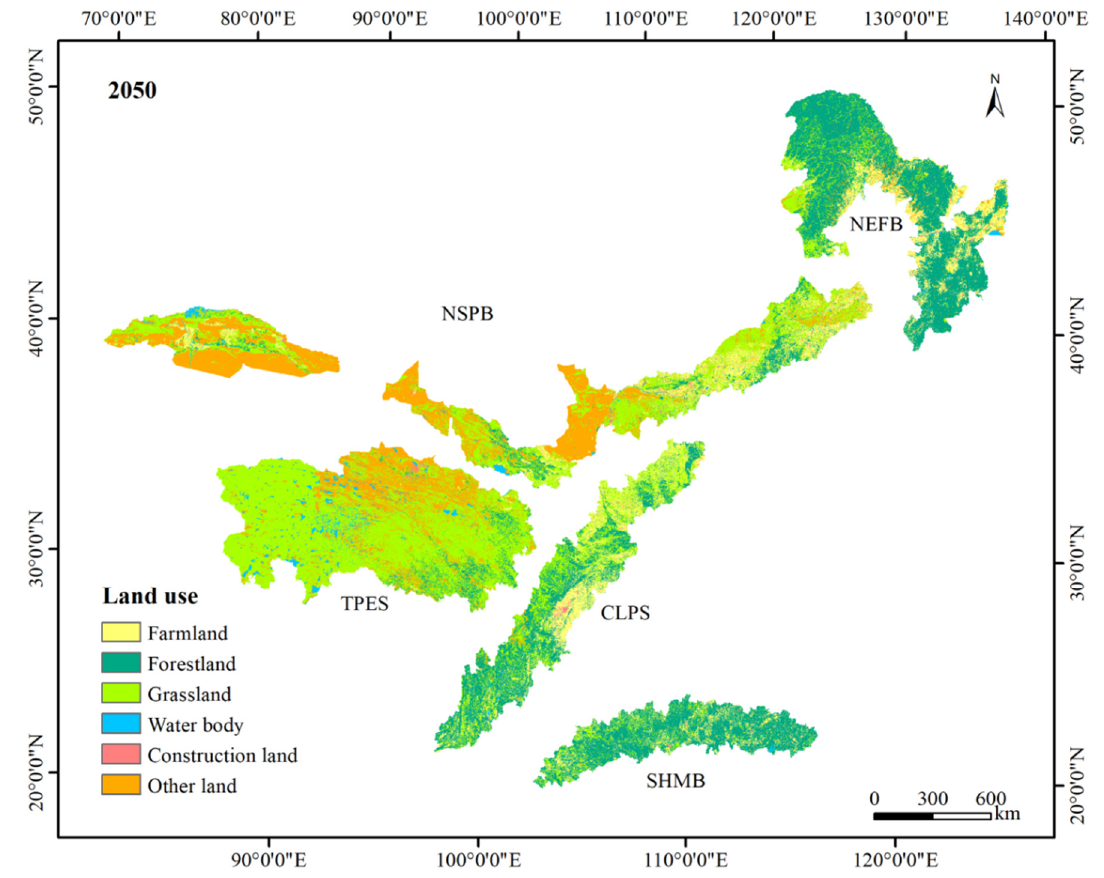
Figure 3. Spatial distribution of land use types in the TSTB in 2050.